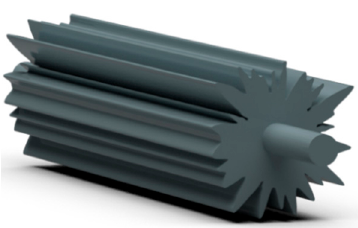
Figure 5. A rotor depicted with randomly generated harmonic roundness components.